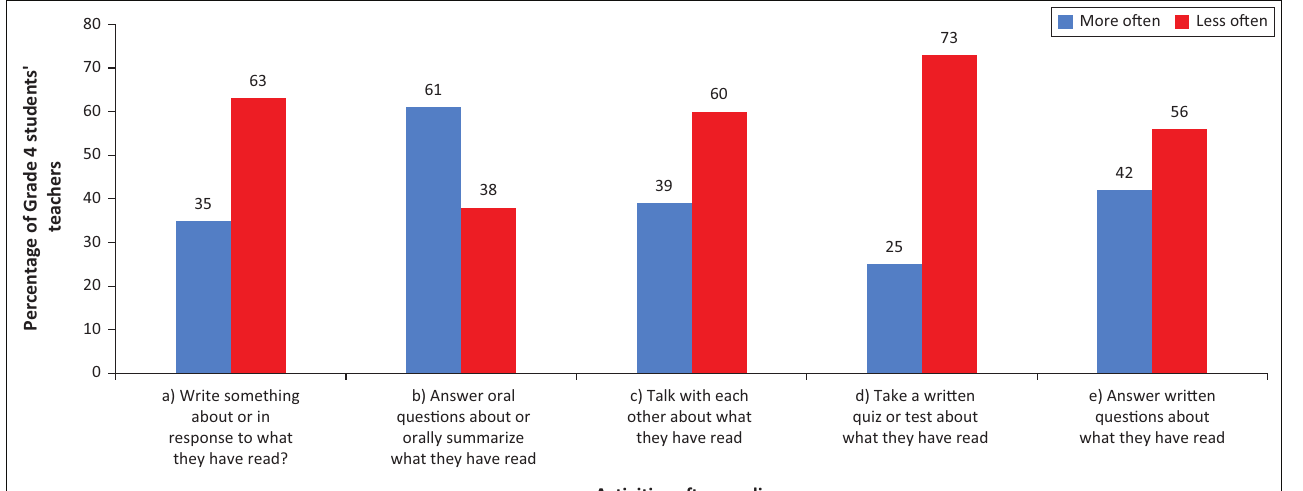
FIGURE 5: Teacher reports of activities after reading.